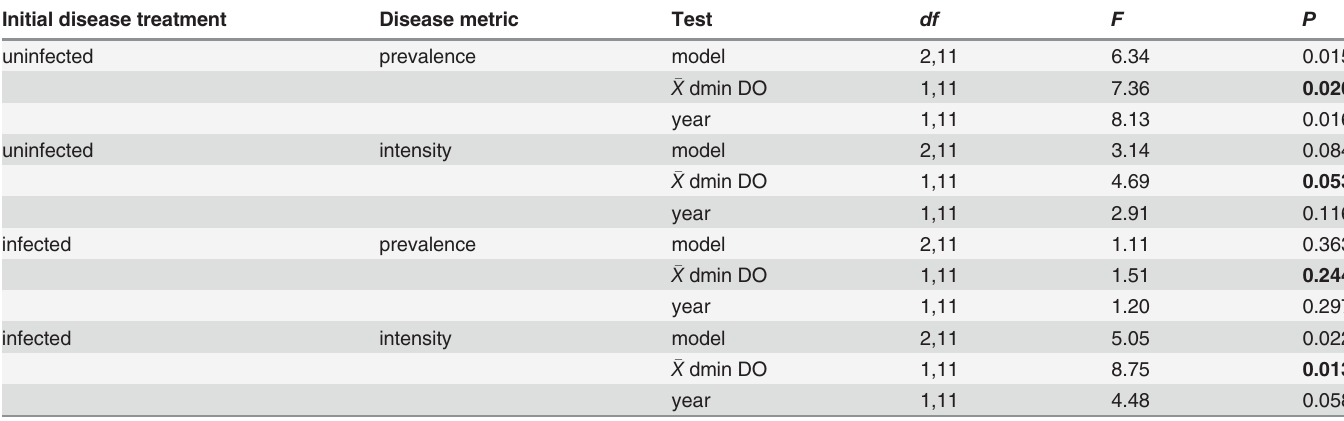
Table 2. Results of ANOVAs testing effects of mean daily minimum DO and year on the prevalence and intensity of P . marinus infections at the end of the fi eld experiment. Initial disease